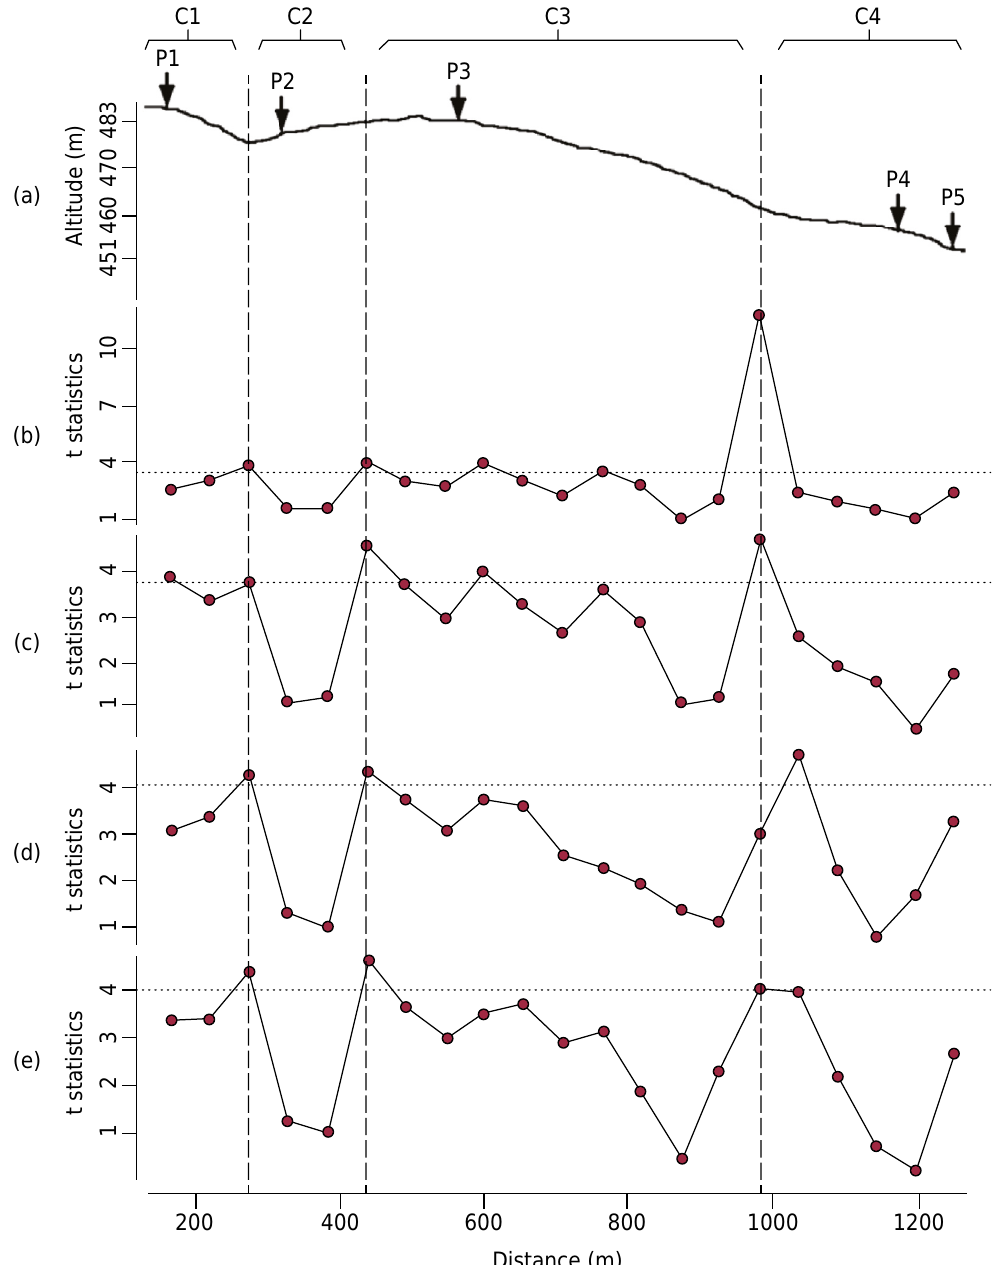
Figure 5. Elevation profile of the transect (a) and the results of the “Split Moving Window” (SMW) analysis and correlation between the t-statistic values for magnetic susceptibility in the layers 0.00-0.05 m (b), 0.05-0.15 m (c), 0.15-0.30 m (d), and 0.30-0.60 m (e) along the transect with points spaced 50 m apart. The peaks above the dotted line (...) indicate significance and the dashed line (---) indicates the peaks of magnetic susceptibility. C: Landscape compartment. P1: Haplic Ferralsol (Dystric, Clayic); P2: Haplic Ferralsol (Dystric, Clayic); P3: Rhodic Eutric Nitisol (Ochric); P4: Rhodic Ferralsol (Dystric, Clayic); P5: Rhodic Ferralsol (Eutric,